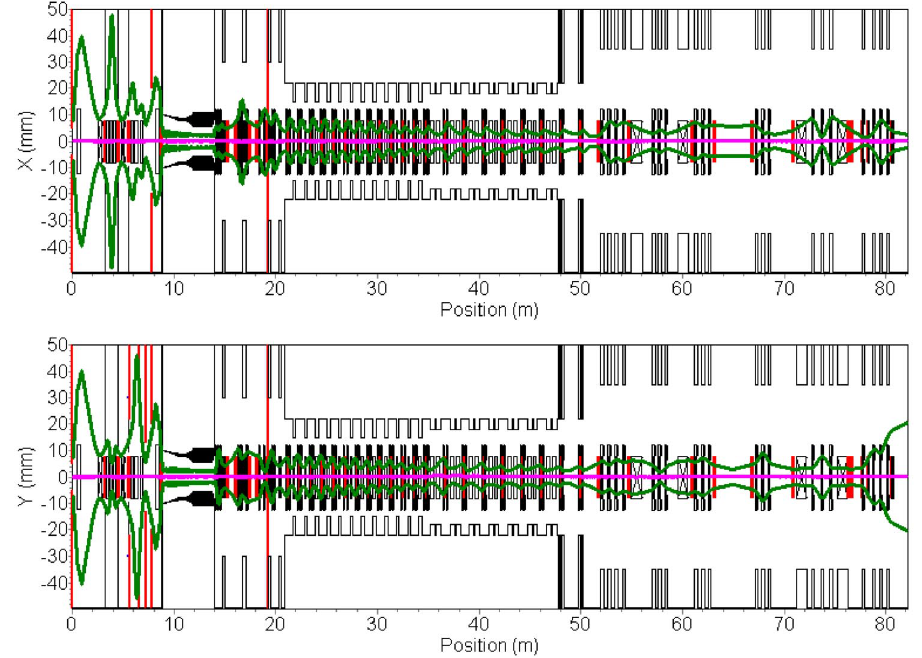
p (cid:4) (cid:1) which is equivalent to the size